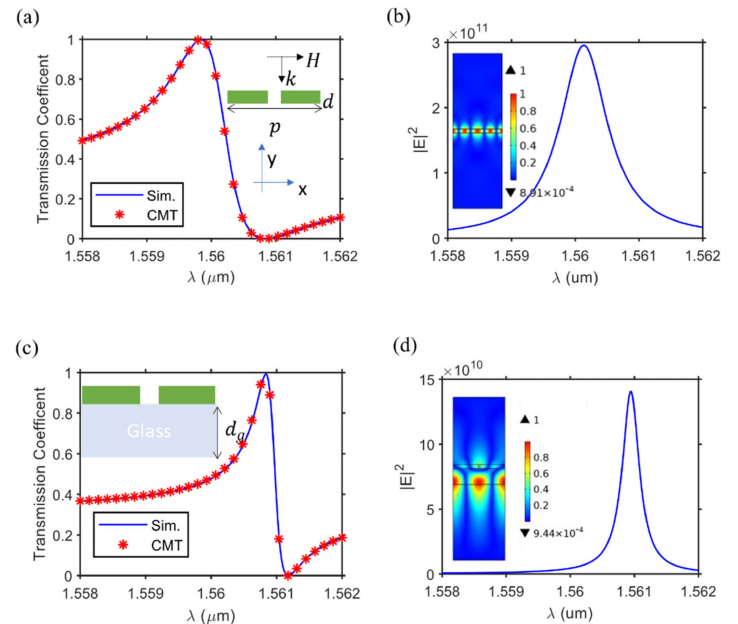
Figure 6. Full wave simulation results for the linear response of the Fano resonators. ( a ) Linear transmission of a periodically patterned dielectric slab for a normally incident plane wave excitation with an electric field along the z axis. The red markers are the CMT standard model results using the parameters given in Table 3 (see Section 5.5 (Fano Resonator Parameters)) for resonator 1 ( w / o glass). ( b ) Average squared value of the electric field inside the Si material shown in ( a ); the inset shows the electric field distribution at resonance, and the scale bar is normalized to the maximum field. ( c ) The same as ( a ), but with an added glass slab. The red markers are the CMT standard model results using the parameters given in Table 3 (see Section 5.5 (Fano Resonator Parameters)) for resonator 2 (w glass). ( d ) The same as ( b ) but for the structure in ( c ). The geometry parameters used are d = 0.1179 µ m, p = 1.4763 µ m, dg = 0.45875 µ m, and slit width = 0.0536 µ